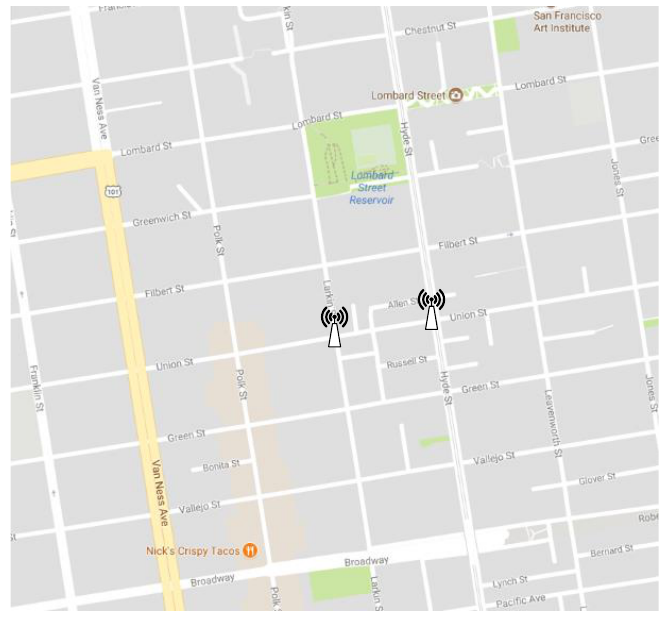
Figure 7. Simulation